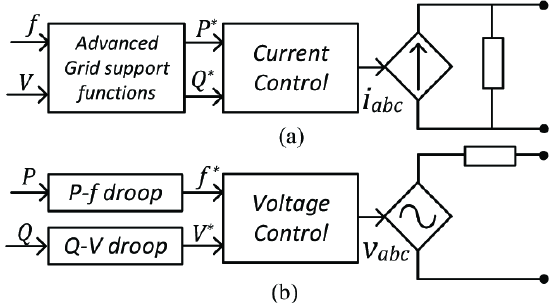
Figure 20. Inverter controllers: ( a ) grid-following control with grid support functions; and ( b ) grid- forming droop control